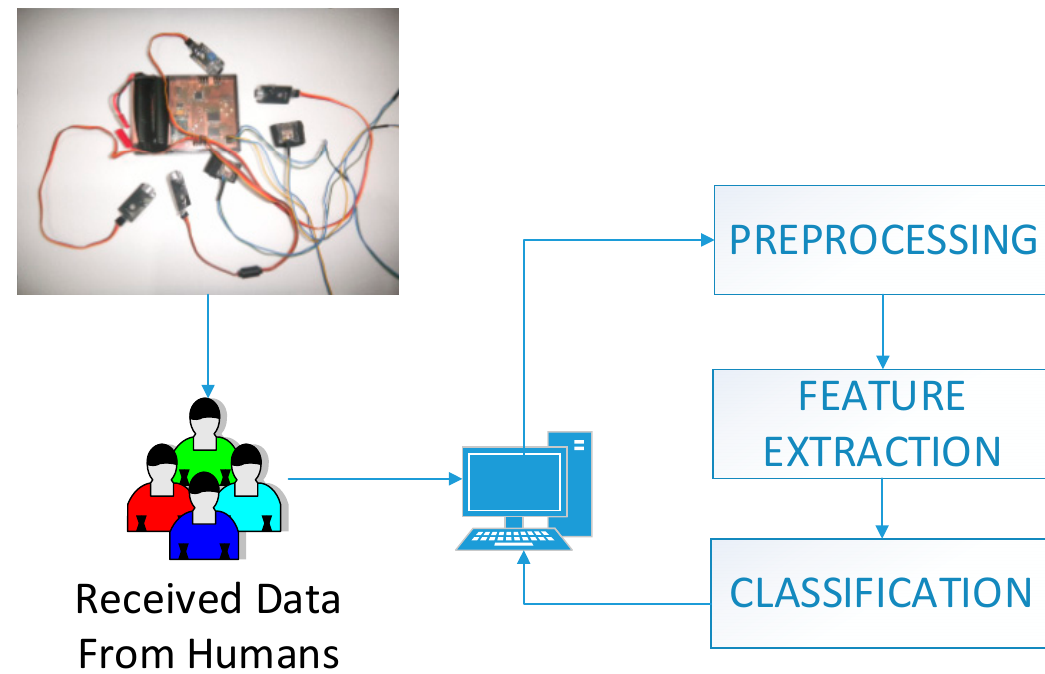
Figure 2. Human–Computer Interface System.